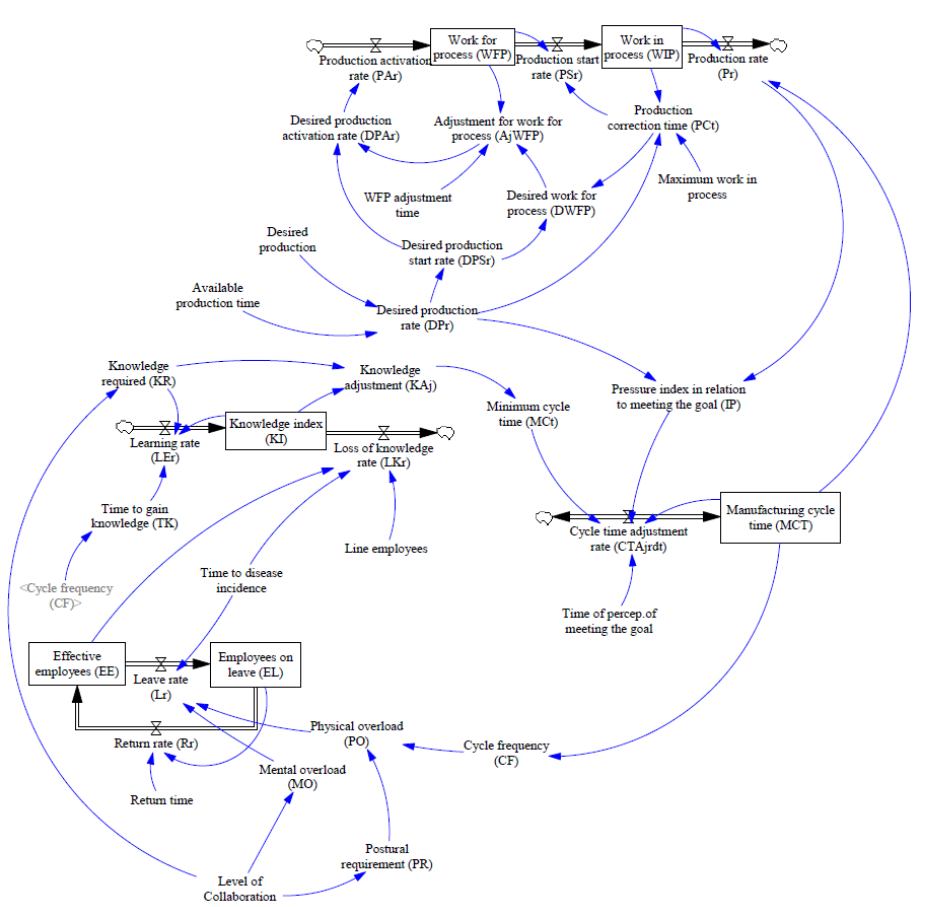
Figure A1. Stock and Flow Map.